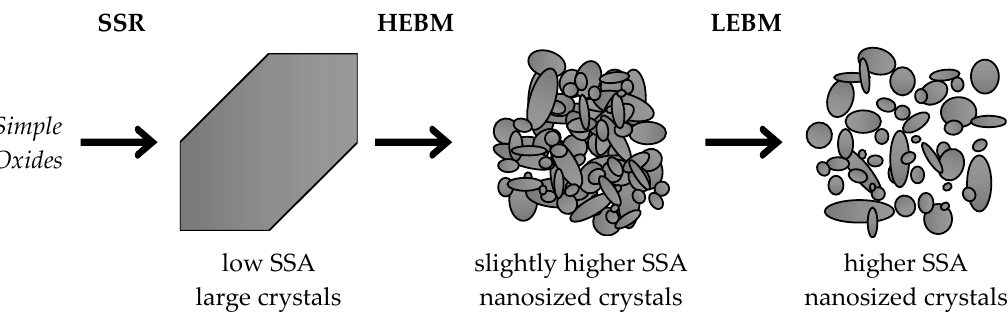
Scheme 1. Simplified view of the material evolution with the synthesis steps of the reactive grinding process. SSR: solid state reaction; HEBM: high energy ball milling; LEBM: low energy ball milling.